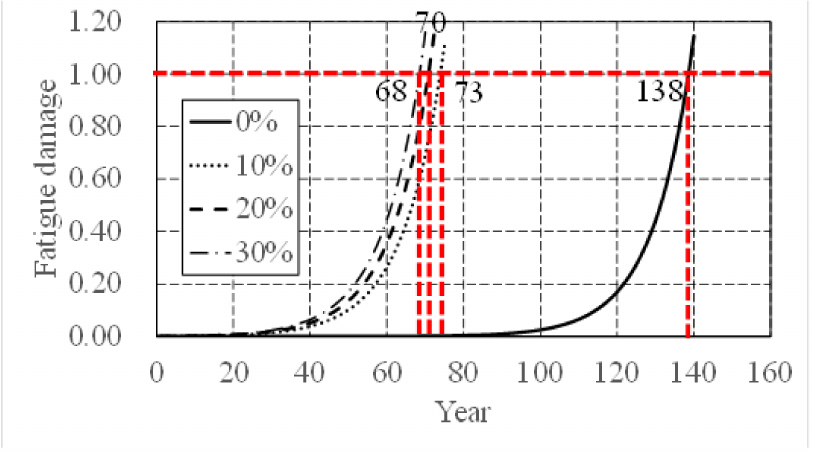
Figure 10. Fatigue-damage accumulation under four ratios of freight